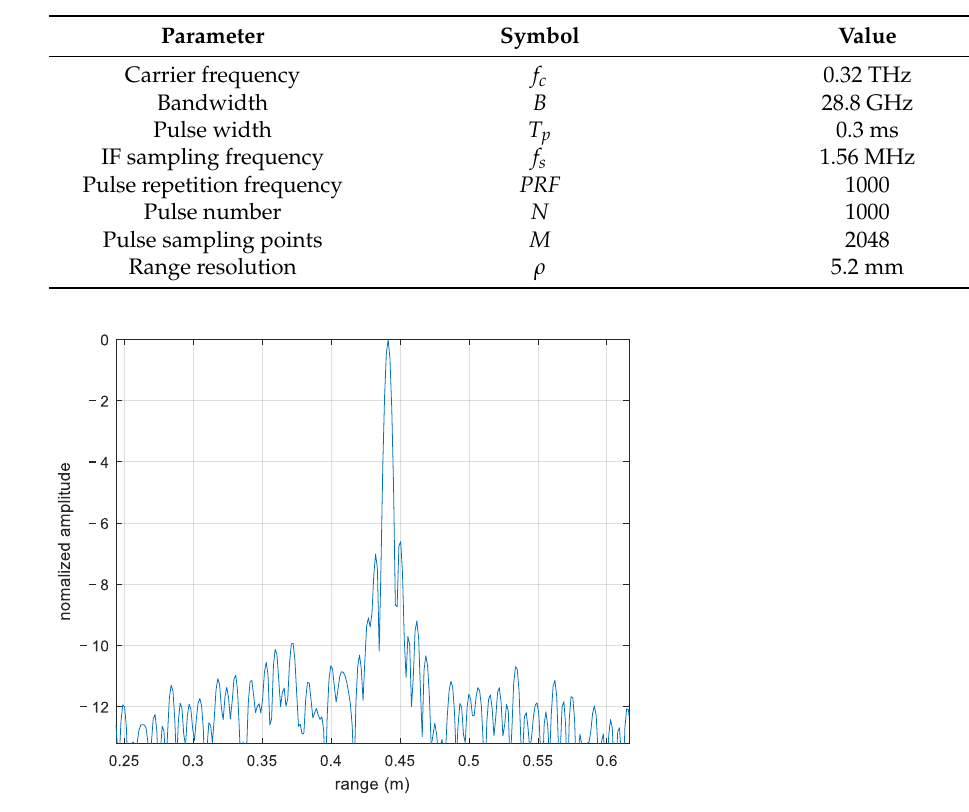
Table 2. Parameters of the radar system.